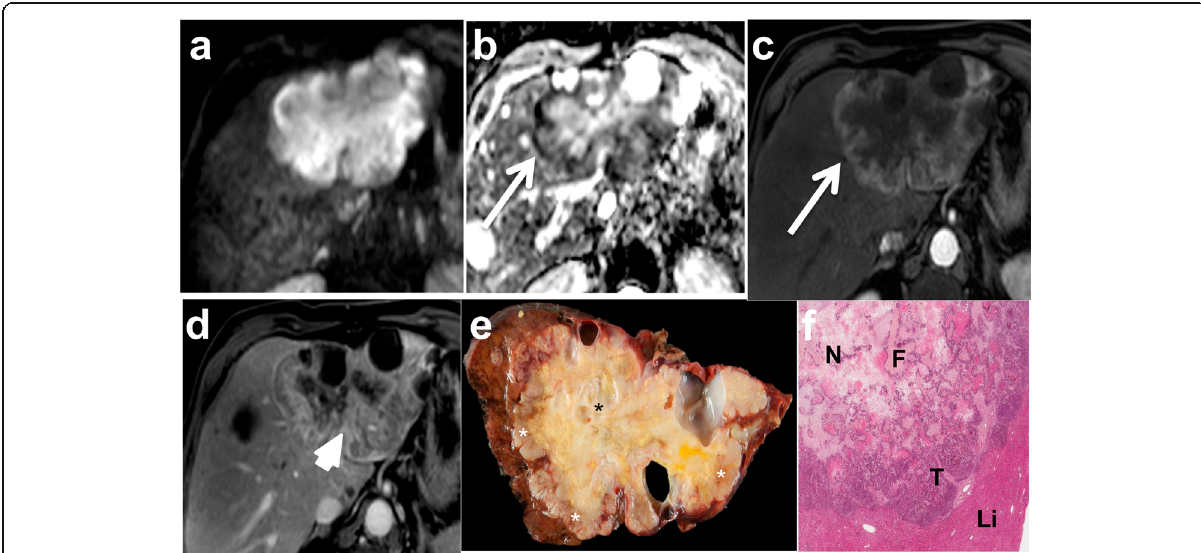
Fig. 15 Dangerous halo in a 58-year-old male patient with metastasis of non-otherwise specified (NOS) adenocarcinoma of the colon treated with 6 cycles of FOLFIRI and cetuximab. The patient had an objective response. Preoperative MR imaging performed after chemotherapy showed an 80 mm lesion in the left liver. On diffusion-weighted image, the periphery of the tumor showed high signal intensity ( a ) and a low apparent diffusion coefficient ( b ) (white arrow). The lesion showed rim enhancement on a contrast-enhanced fat-suppressed gradient recall echo T1- weighted image obtained during the hepatic arterial phase ( c ) (white arrow) consistent with the presence of peripheral remnant tumor cells. There was progressive enhancement of the central part of the lesion on delayed (3 minutes) phase ( d ) (white arrow) corresponding to central fibrosis deposition. Gross pathology ( e ) confirmed the presence of central necrosis with bands of fibrosis (black star) and of a polylobated peripheral crown of tumoral glands (white stars) corresponding the dangerous halo. Histology ( f ) showed viable tumor glands (T) infiltrating the surrounding liver parenchyma (Li) with central necrotic (N) and fibrotic (F) changes